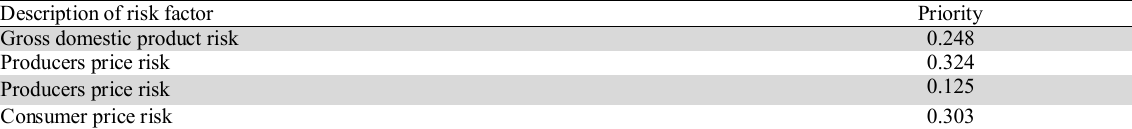
The summary of risk factors associated with inflation